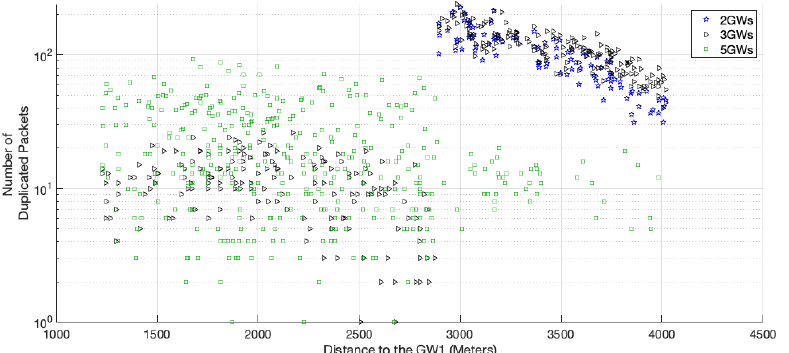
Figure 9. Number of duplicated packets per ED for a network with 2000 EDs using channel hopping